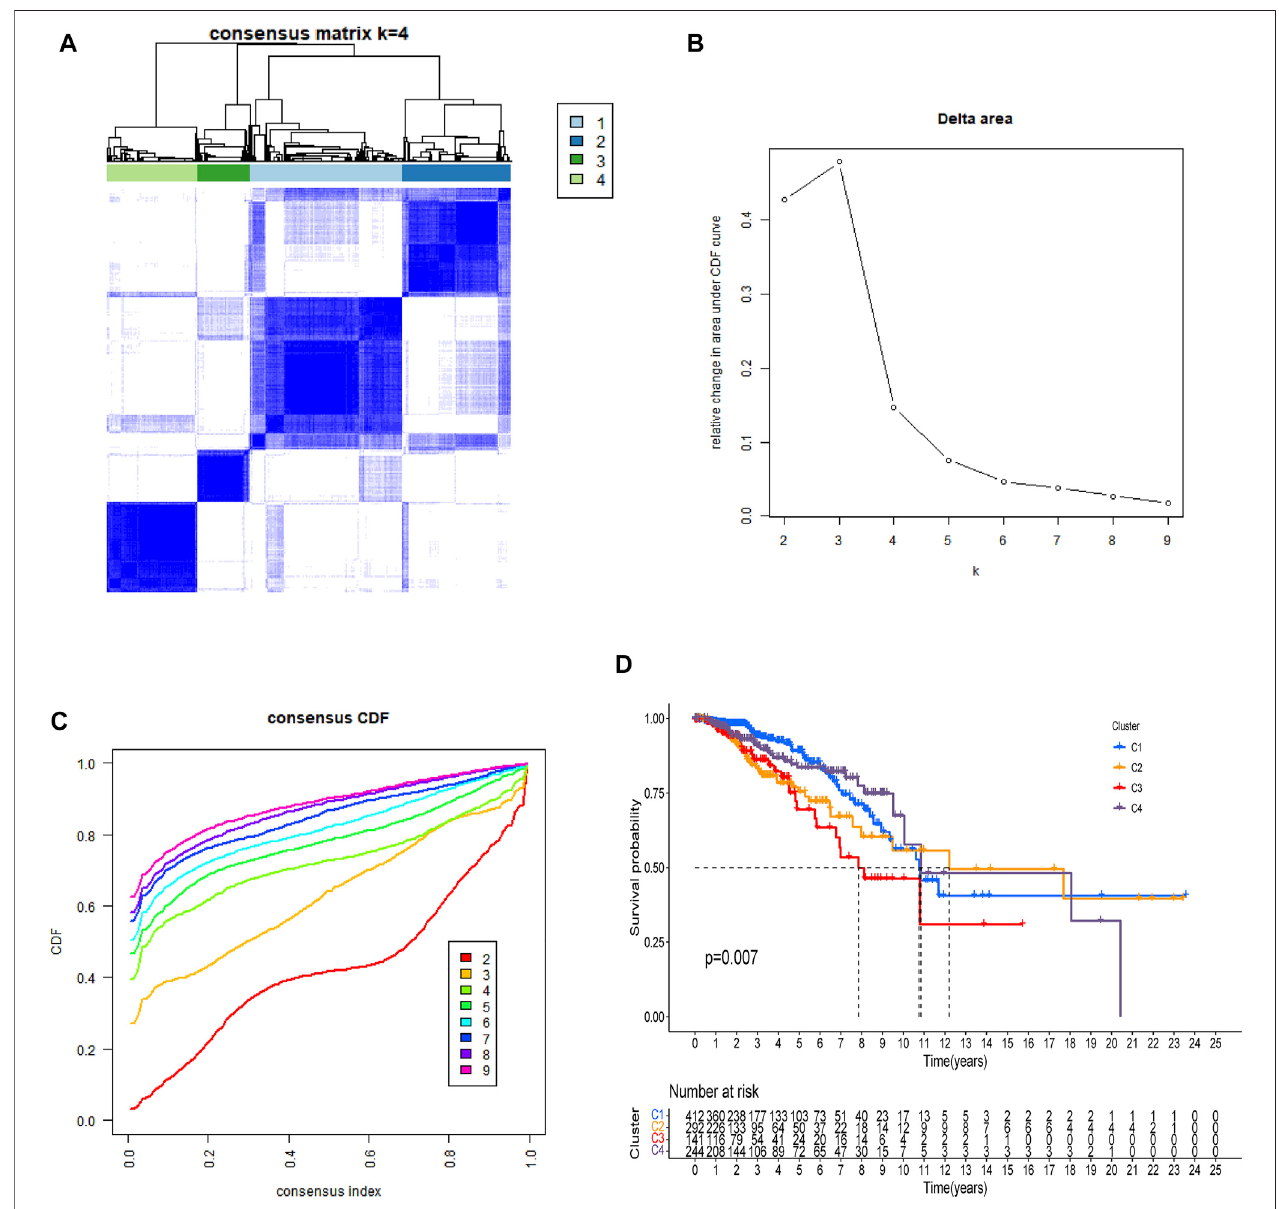
FIGURE 3 | All patients were classi fi ed using consensus matrix = 4 (A) , delta are < 0.2 (B) , and consensus CDF = 4 (C) , and Kaplan-Meier curve of OS was compared between them (D) .